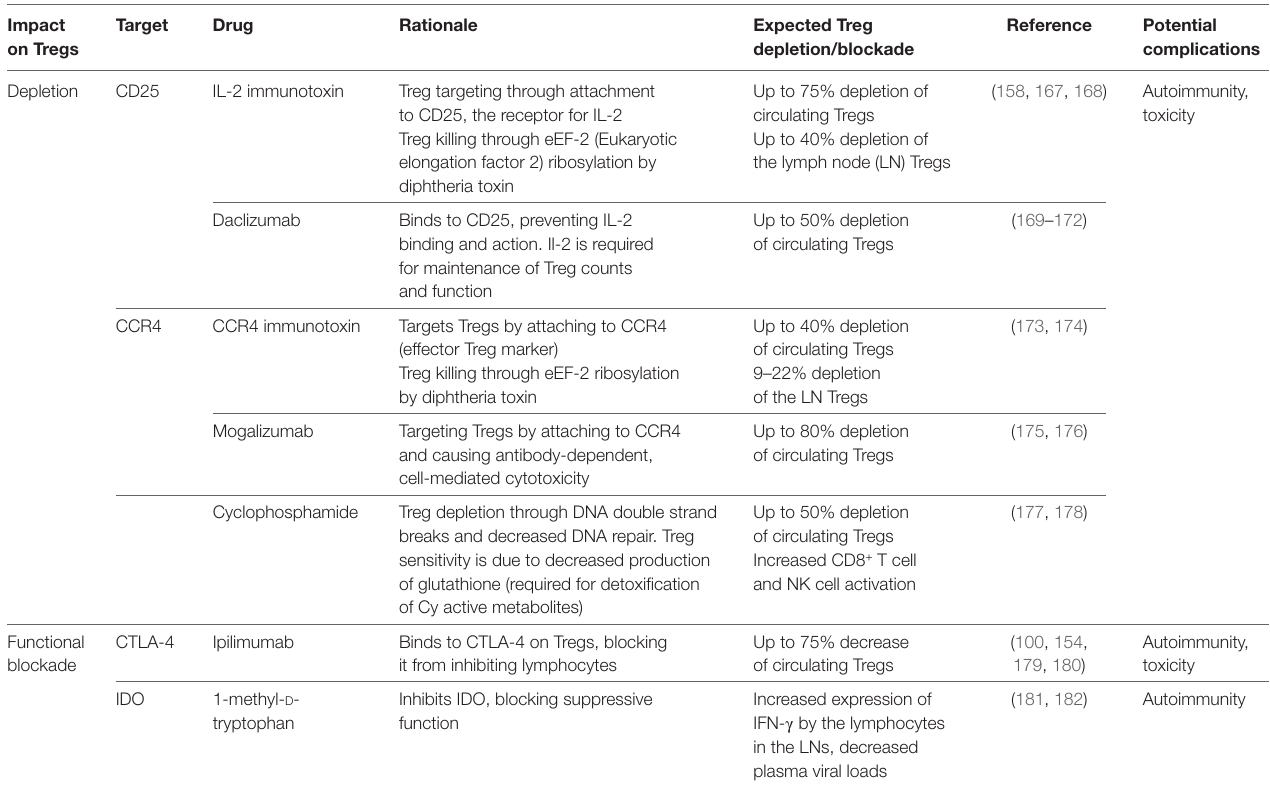
TAble 2 | Strategies for targeting T regulatory cells (Tregs) and/or their function. impact on